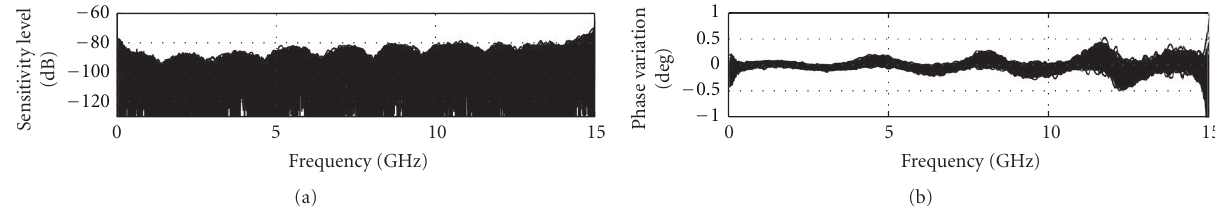
Figure 6: Sensitivity calculated based on a pair of full TSAR scans (200 positions) with a broadband load instead of the antenna. The load is physically moved with the prototype system to 200